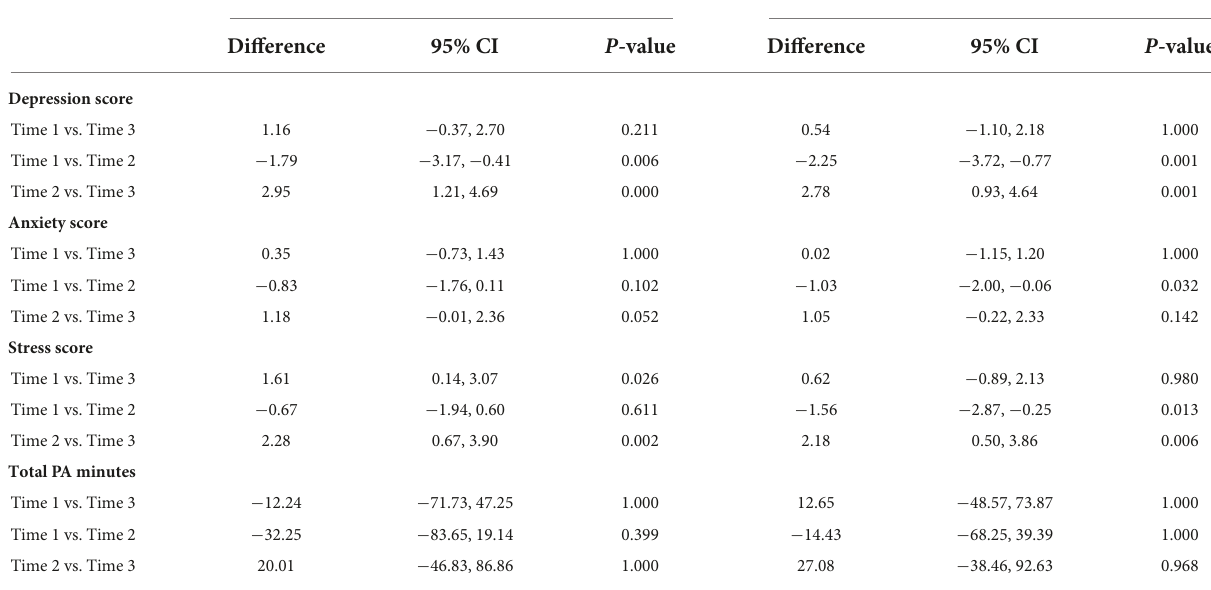
TABLE 4 Changes in mental health and physical activity outcomes in cross-sectional